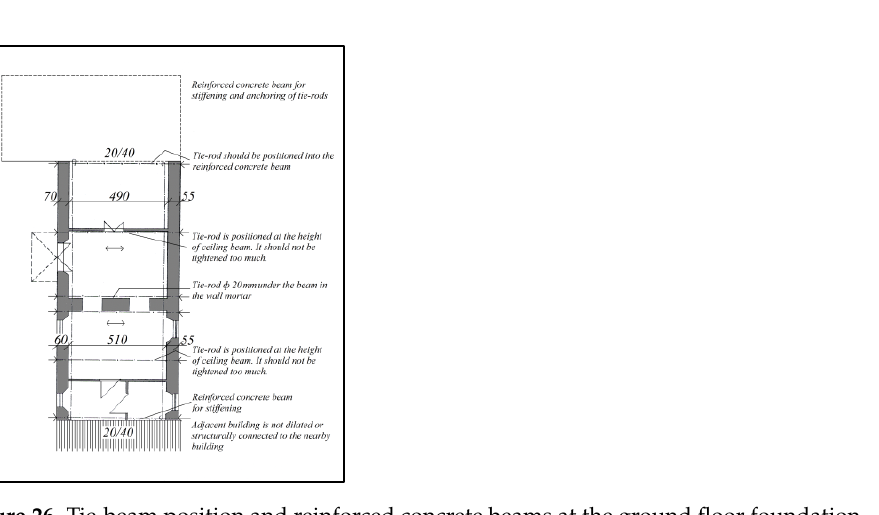
Figure 26. Version with interior ring beam fixed at the positions that suffered severe damage. Figure 26. Tie-beam position and reinforced concrete beams at the ground floor foundation.